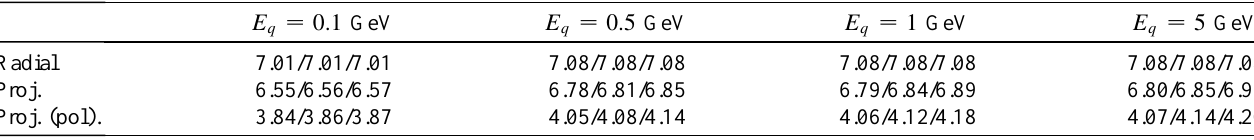
TABLE I. FWHM values for radial SPF and projected ones in both normal and polarized cases for different particle energies. Numbers separated by slashes in each column correspond to 0.1%, 0.05%, and 0.01% cutoff levels, respectively. (cid:69) (cid:113) (cid:173) (cid:48)(cid:46)(cid:49) GeV Radial